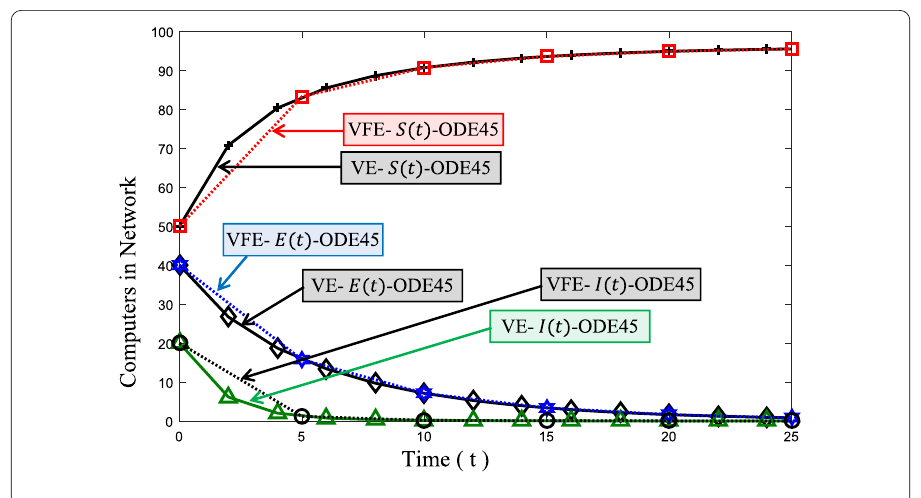
Figure 17 Convergence curves of ODE45 for VE ( h = 2) and VFE ( h =